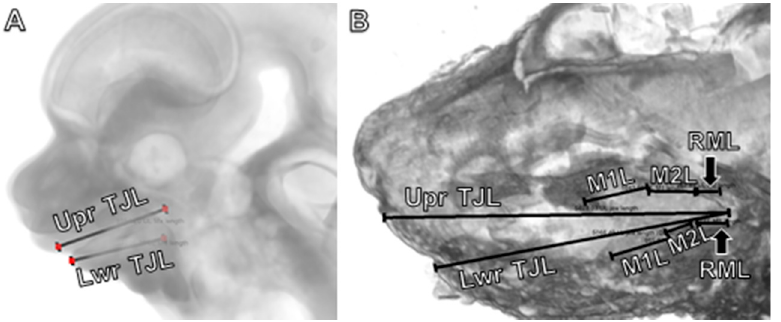
Figure 1. Linear measurements used to define jaw and molar lengths in ( A ) embryonic (E12) and ( B ) perinatal (E18) mice for total jaw length in the upper and lower jaws. Retromolar length is not yet visible in the embryo ( A ). Abbreviations: Lwr, lower jaw; M1L, first molar length, M2L, second molar length, M3L, third molar length; RML, retromolar length; TJL, total jaw length; Upr, upper